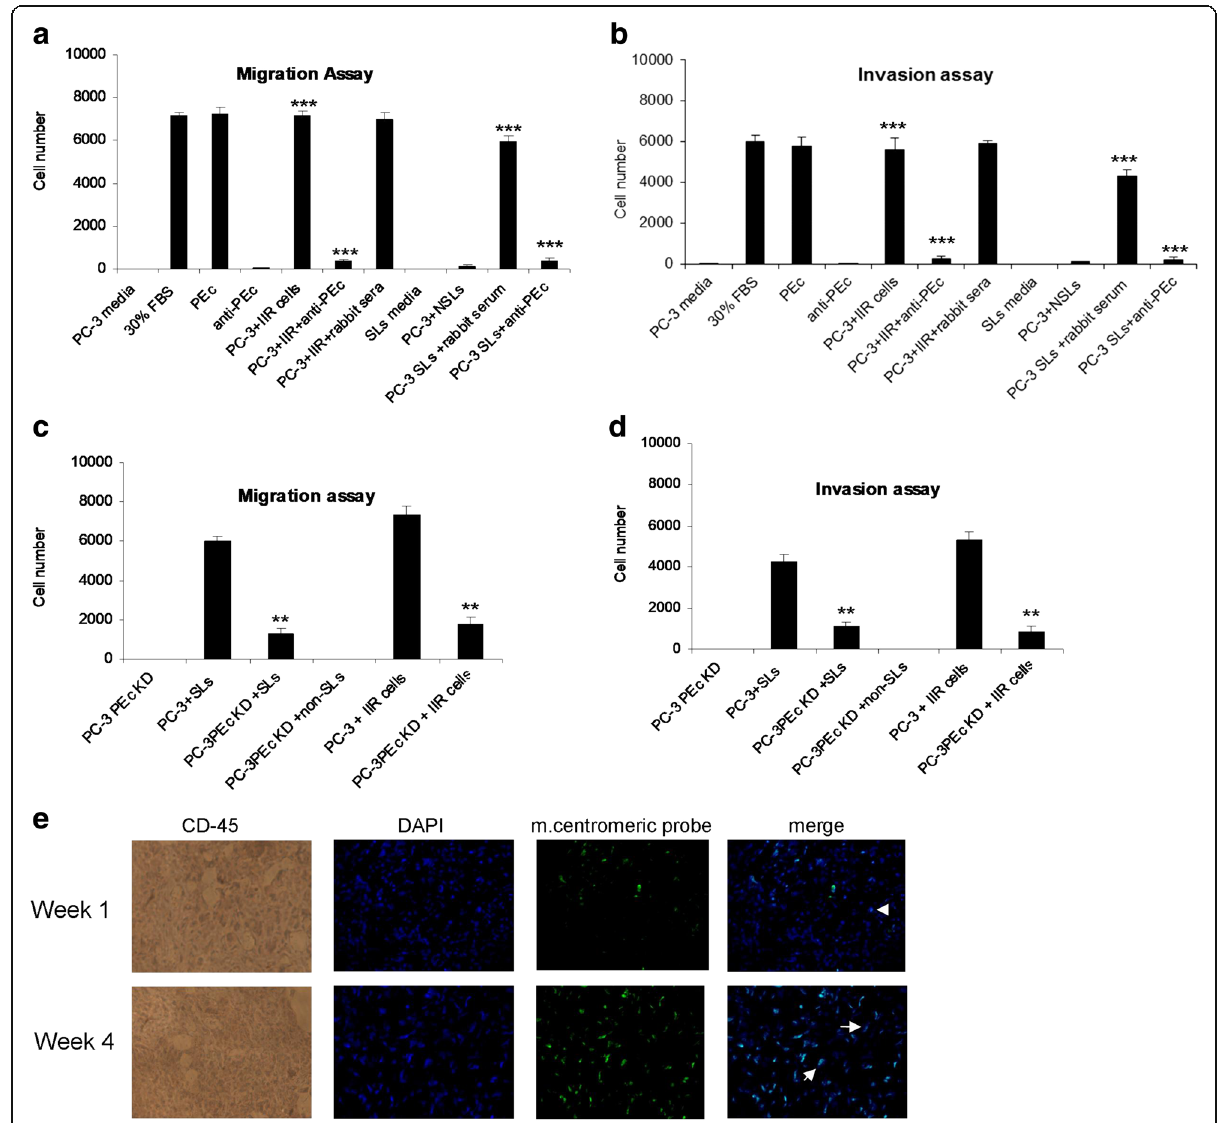
Fig. 2 Migration and invasion assays assessing the effects of PEc secreted by the wt and modified PC-3 cells, on MSC mobilization. a and b : Media obtained from PC-3 cells co-incubated with sensitized lymphocytes or with cells of the human innate IR, induced HMSC migration and invasion. This effect was suppressed by the introduction of the anti-PEc antibody (1/100, 30 min) in both cases for both cell lines. c and d : The media obtained from PC-3 IGF-1Ec KD cells after co-incubation with sensitized lymphocytes, presented a significantly lower effect on the migration and invasion capacity of the MSC compared to the media obtained from PC-3 cells under the same treatment. Similar results were observed for DU-145 cells. E: Detection of mouse MSC in human tumors in SCID mice as CD-45 negative cells that posses mouse centromeres, in 1 and 4 weeks. The arrows indicate fusion between mouse and human cells (**: p < 0.005, ***: p <